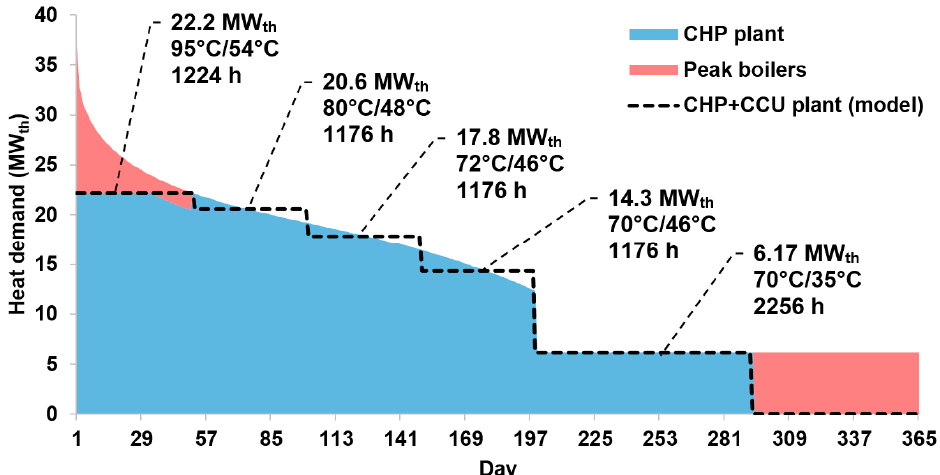
Figure 3. Heat demand curve in the analyzed DHS.